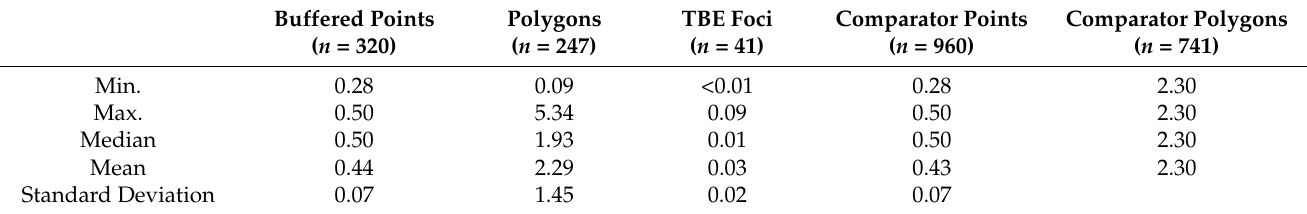
Table 2. Size of self-reported TBE infection points and polygons, confirmed natural TBE foci, and comparator points and polygons (km 2 ).